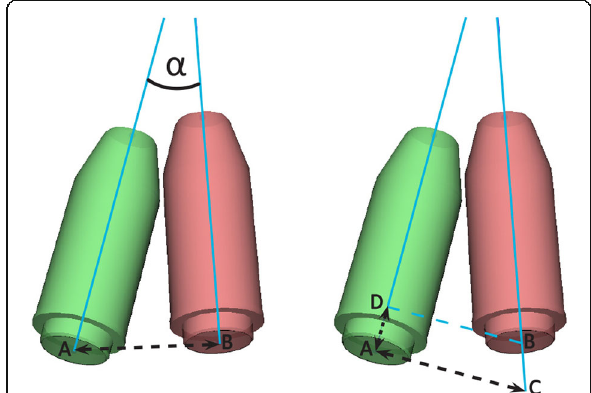
Fig. 5 Deviation measurement. Global (point A – B), lateral (point A – C), depth (point A – D) and angular ( α ) deviations